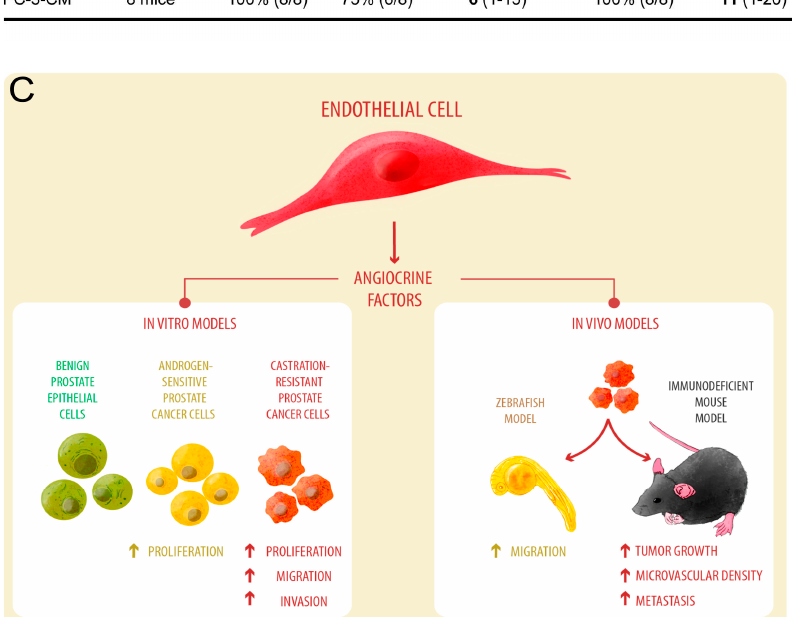
Figure 4. HUVEC-CM increased metastatic foci in host tissues of mice xeno-transplanted with PC-3 cells. ( A ) Representative images of metastatic foci in host kidney and liver tissues. Metastatic PC-3 cells were immunohistochemically detected using an anti-human Ki-67 antibody. Human tonsil was used as positive control for human Ki-67 expression. The tonsil has a characteristic pattern for this marker, since the surface of the epithelium includes a high positive (parabasal layer), low positive (intermediate layer) and negative (basal and superficial layers) zones. ( B ) Quantification of the number of mice with metastasis (metastasis incidence) and the number of metastatic foci per field in each organ (“Average metastatic lesion (range)” ( n = 8). ( C ) Proposed model of the paracrine effects of endothelial cell CM on prostate epithelial cell lines in in vivo and in vitro